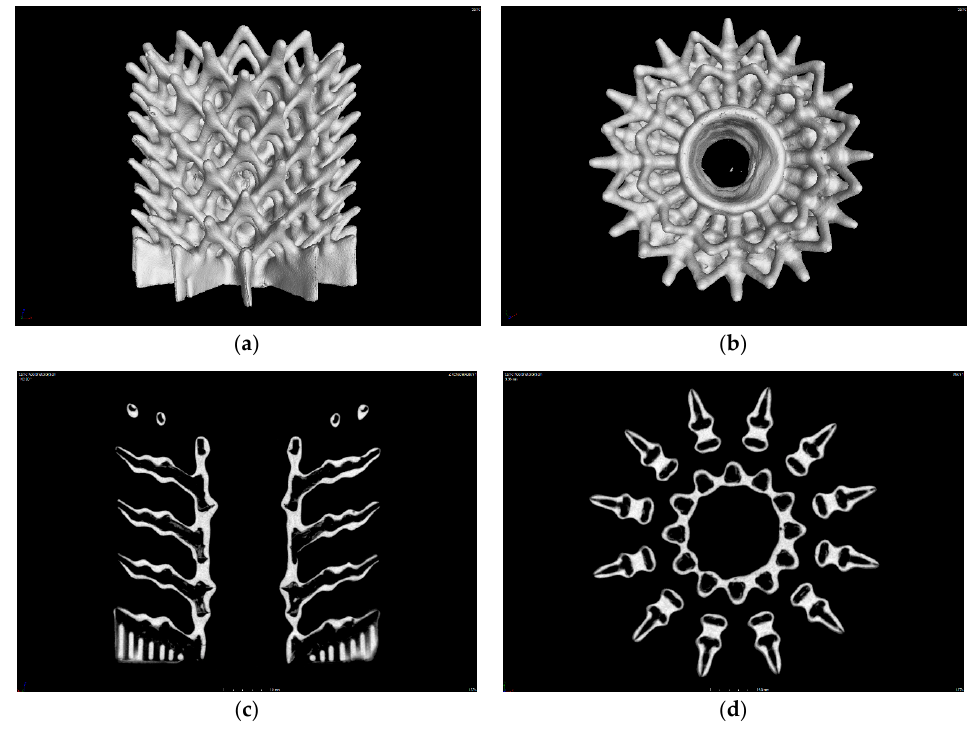
Figure 14. CT analysis of the sintered silicon carbide (SSiC) structure (outer diameter approximately 25 mm): side view ( a ), top view ( b ), vertical cut ( c ), and horizontal cut ( d ).